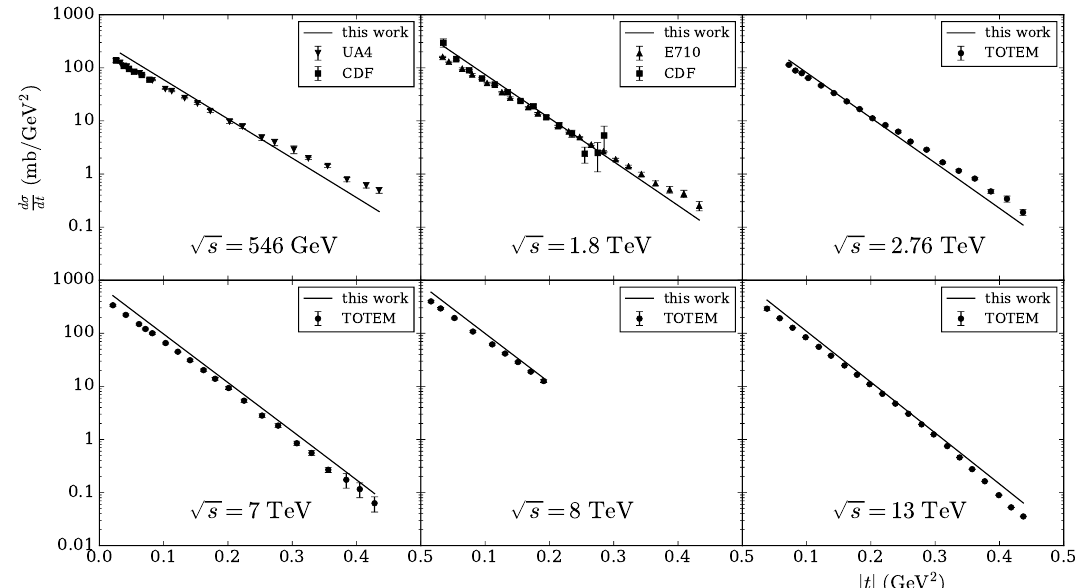
Figure 3 . The di(cid:11)erential cross section as a function of j t j . The solid lines represent our calculations obtained with the experimental data in the range, 546 GeV (cid:20) with their errors.